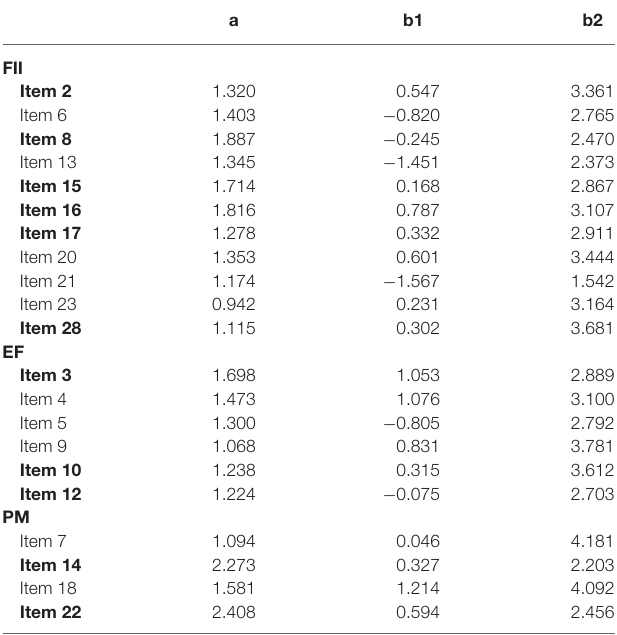
TABLE 4 | Parameters estimated from the three graded response models (GRM).